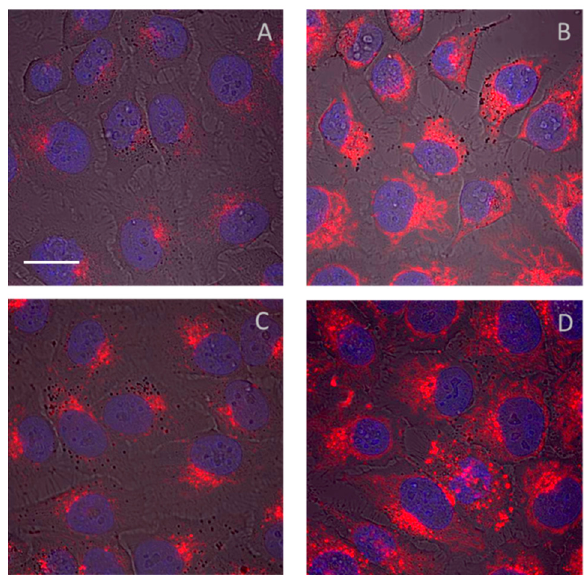
Figure 2. Intracellular localization of pHPMA polymer conjugate labeled with Dyomix 630 ( A ), Cy5 ( B ), ATTO647 ( C ), and Cyanine 5.5 ( D ). The HeLa cells were incubated for 24 h with the labeled polymers. The amount of fluorescently labeled polymer conjugates added to the cell suspensions was normalized to the dye content (1 μ g/mL). The fluorescently labeled polymers (red color) were excited at 647 nm, and the emitted light was detected using a 640–740 nm filter. Nuclei were visualized by labeling with Hoechst 33342 dye excited at 405 nm, and emitted light was detected using a 425–500 nm filter, scale bar 20 μ m.